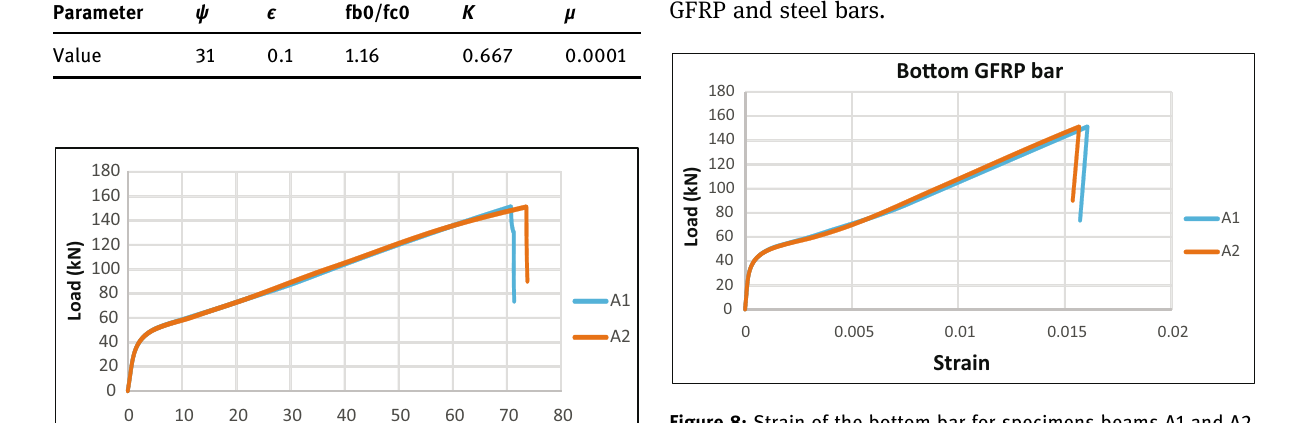
Figure 8: Strain of the bottom bar for specimens beams A1 and A2.